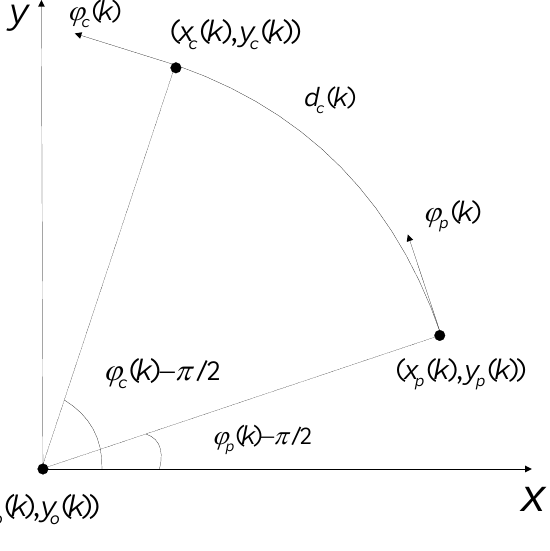
Figure 1. The geometric relationship between two neighboring